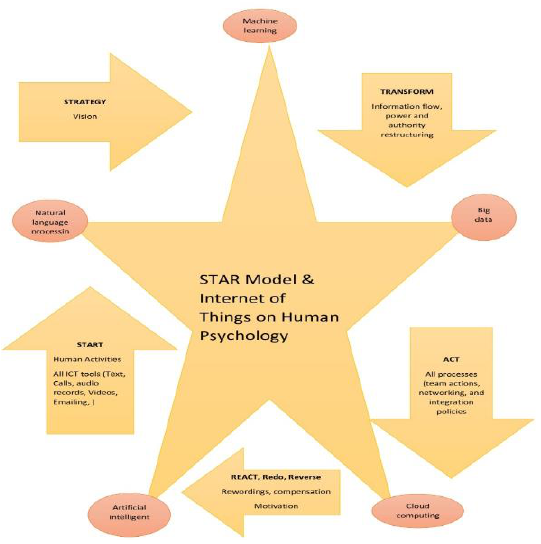
Figure 6 . STAR Model and internet of things on human psychology by